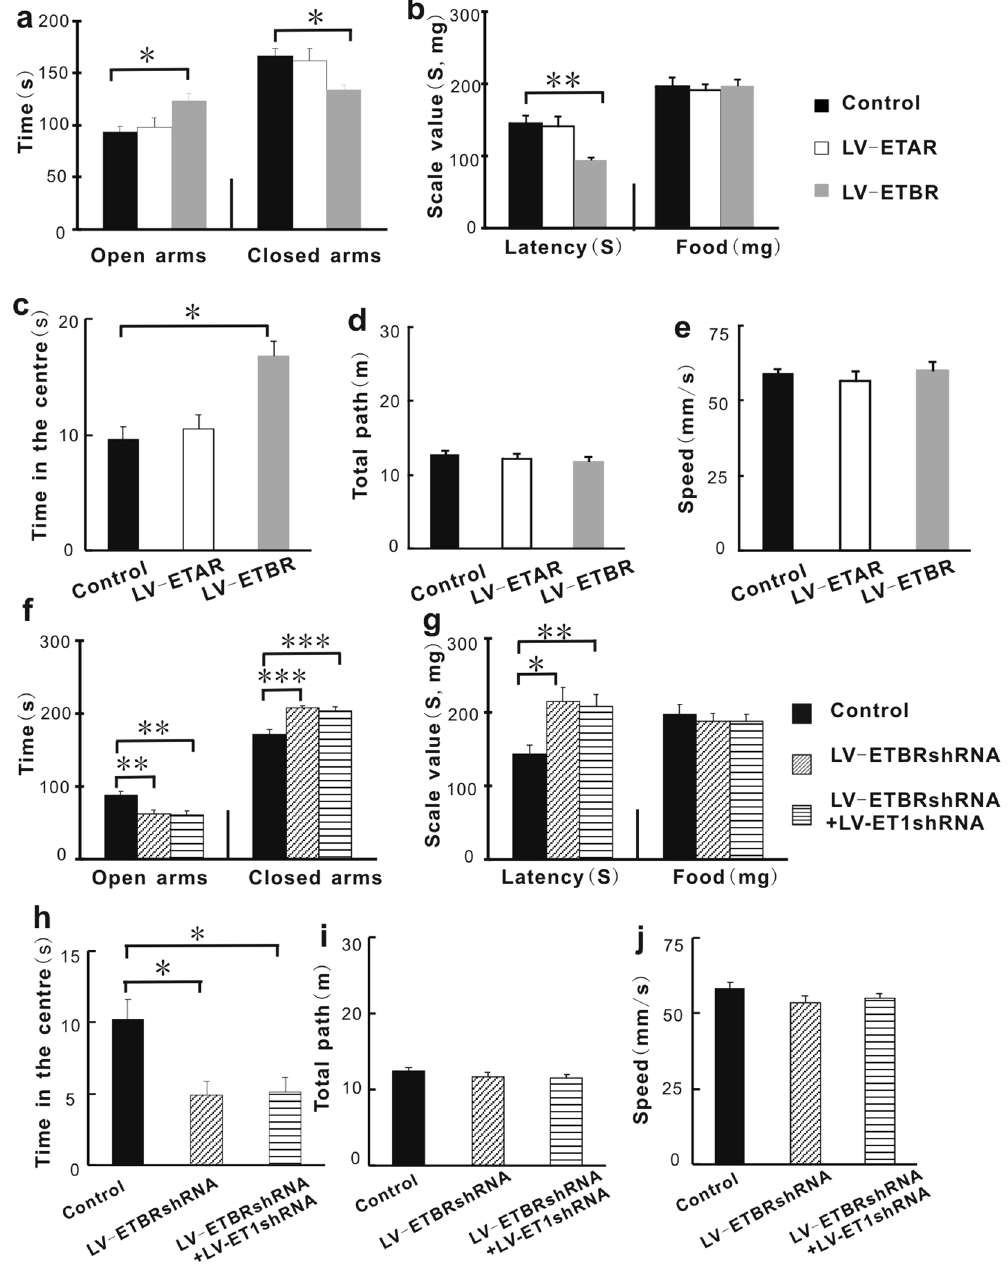
Figure 2. Up-regulating ETBR gene expression in the BLA with ETBR lentiviral activation particles (LV-ETBR) attenuated anxiety-related behaviors. Knocking down ETBR gene expression in the BLA increased anxiety-related behaviors, and down-regulating both ETBR and ET1 had no additional anxiogenic effect. ( a ) The time spent in the open arms and the time spent in the closed arms in the elevated plus maze test. ( b ) The latency time and the food intake of the mice in the novelty-suppressed feeding test. ( c ) The time spent in the center of the open field box. ( d , e ) The total path length and the speed in the open field test. ( f ) The time spent in the open arms and the time spent in the closed arms in the elevated plus maze test. ( g ) The latency time and the food intake of the mice in the novelty-suppressed feeding test. ( h ) The time spent in the central area in the open field test. ( i , j ) Locomotor activity in the open field test. (n = 16/group). * P < 0.05, ** P < 0.01, *** P < 0.001, two-way ANOVA test with one factor as repeated measure for 2a and 2f, one way ANOVA post hoc test for 2b–2e and